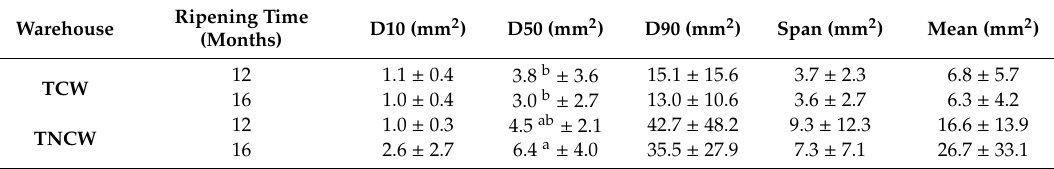
Table 4. Size frequency distribution percentiles (D10, D50, D90), mean and span (Equation (5)) of Nostrano Valtrompia cheese openings measured with image analysis.